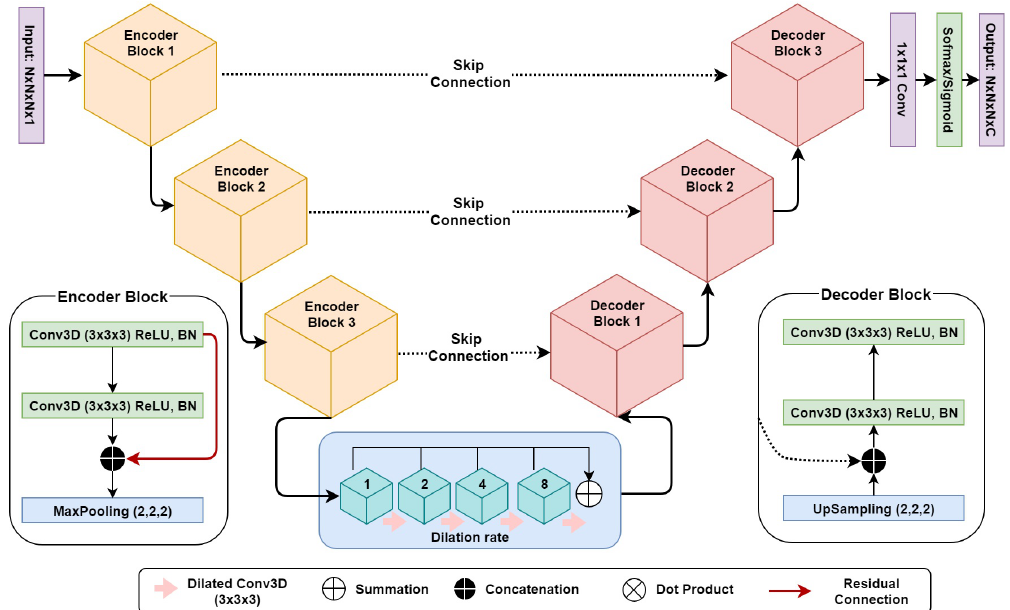
Figure 2. This figure illustrates the architecture of the 3D Dilated Residual U-Net (3D DR-UNet) comprising encoder/decoder blocks. The bottleneck comprises four convolution layers with successively increasing dilation rates from 1–8, to increase the receptive field size. In the encoder block, the red arrow represents the residual connection between convolution